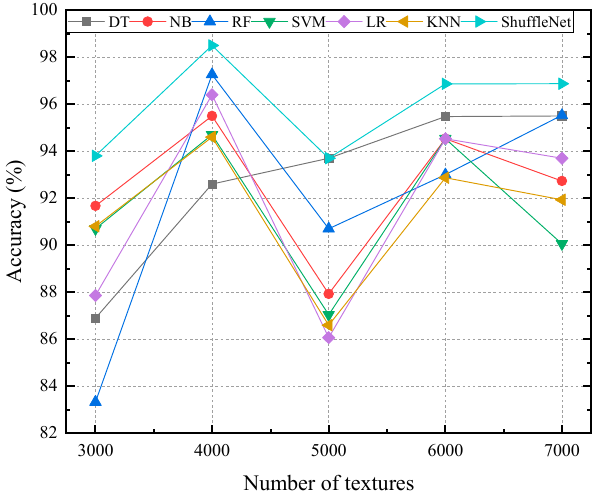
Figure 13. Performance comparison of different classification models. Table 3. The results of different classification